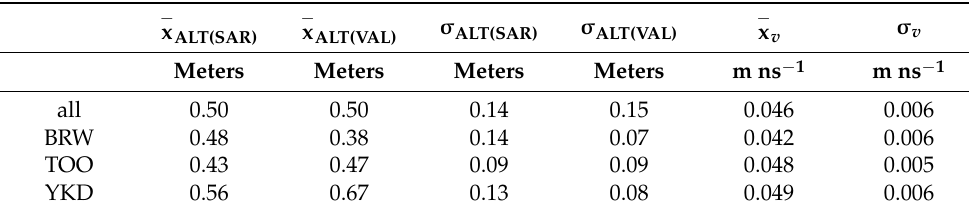
Figure 3. GPR results from within the YKD swath. ( a ) Processed radargram with time-depth- conversion applied using site-calibrated wave velocity. The interpreted reflection from the permafrost table is indicated in red. ( b ) Comparison between GPR-measured ALT and thaw probe data with one-to-one line. ( c ) Location where the radargram in ( a ) was measured (white arrow), also showing the SAR ALT product overlain on aerial imagery. The GPR track is shown in the southeast corner of Figure 2c. − Table 1. Average ( x) and standard deviation ( σ ) for the SAR and validation (VAL) datasets and for the GPR wave velocity, v